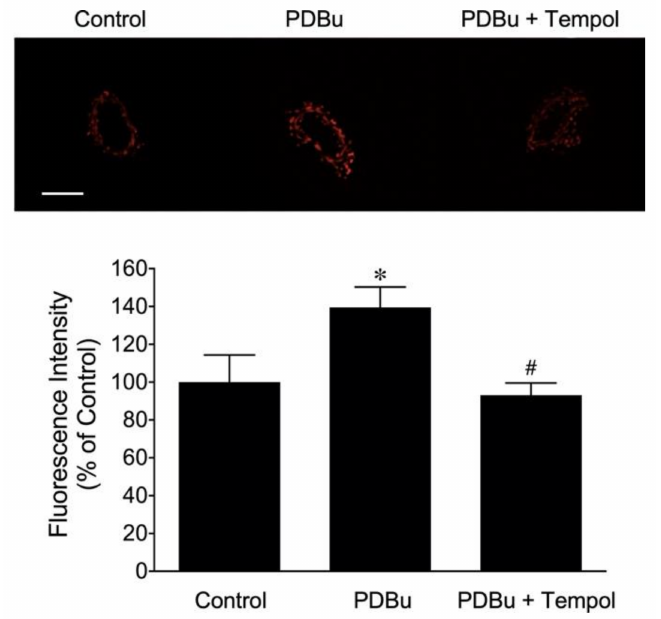
Figure 4. Detection of superoxide production in porcine coronary arterioles. Dihydroethidium (DHE)